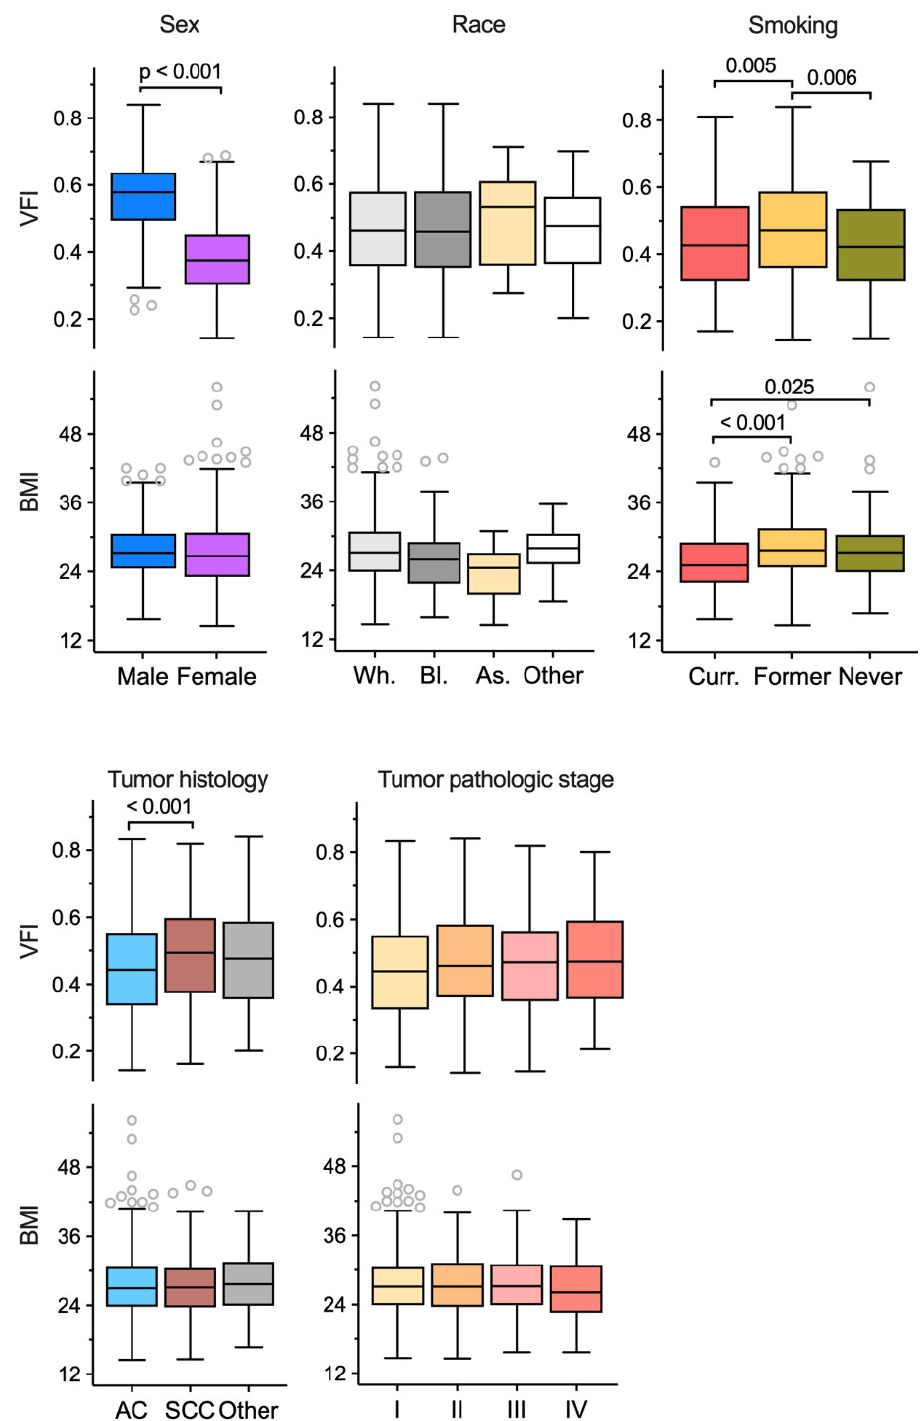
Figure 4. Association of visceral fat index (VFI) with various demographic and clinical features in non-small cell lung cancer patients. VFI was quantified using computerized tomography images of 947 patients at the L3 lumbar vertebral level. Tukey boxplots of VFI and body mass index (BMI) are shown for different subgroups of patients. Median, inter-quartile range, minimum and maximum values of non-outliers, and all outliers are depicted. Welch t and Welch ANOVA (with Games–Howell procedure) tests were used for comparisons, and p values ≤ 0.05 in the comparisons are presented. AC, adenocarcinoma; As., Asian; Bl., black; Curr., current; SCC, squamous cell carcinoma; Wh., white.